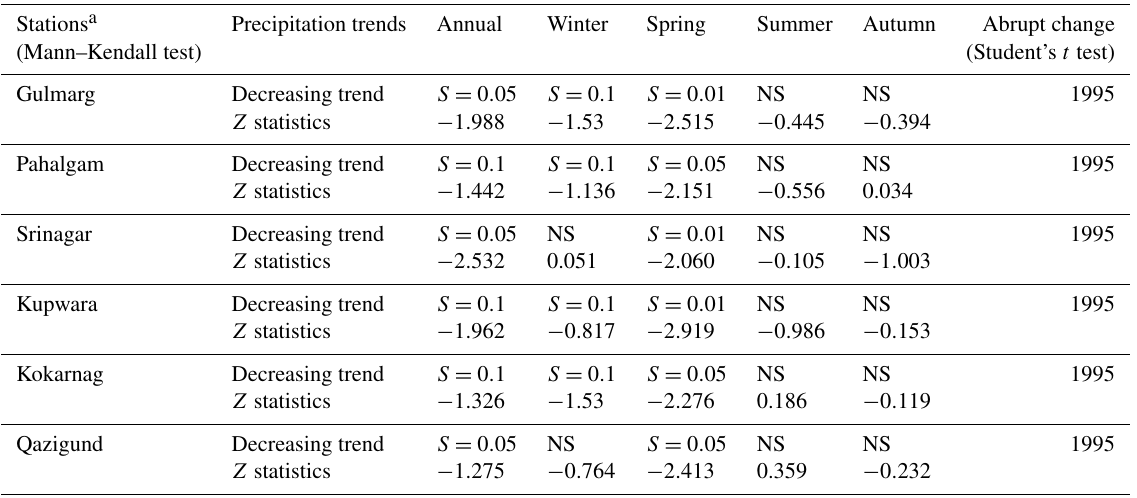
Table 2. Annual and seasonal precipitation trends in Kashmir valley during 1980–2016. Stations